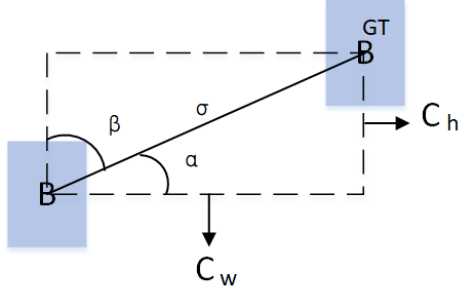
Figure 6. The scheme for calculation of angle